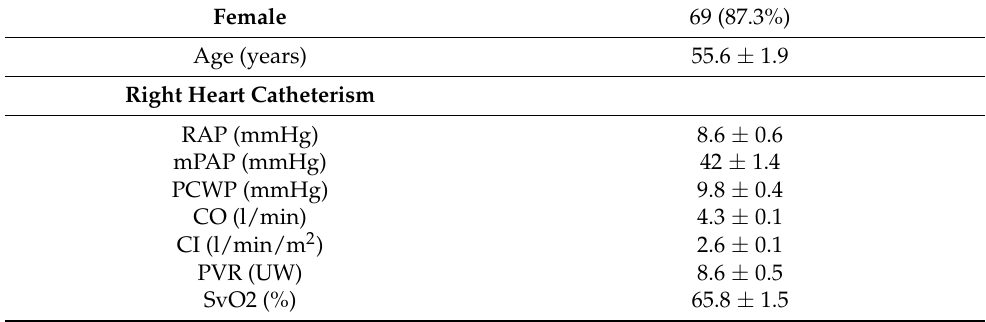
Figure 1. Patient selection flow chart. PAH: Pulmonary Arterial Hypertension; CTD-PAH: Pulmonary Arterial Hypertension Associated with Connective Tissue Disease. Table 1. Baseline characteristics of 79 CTD patients.